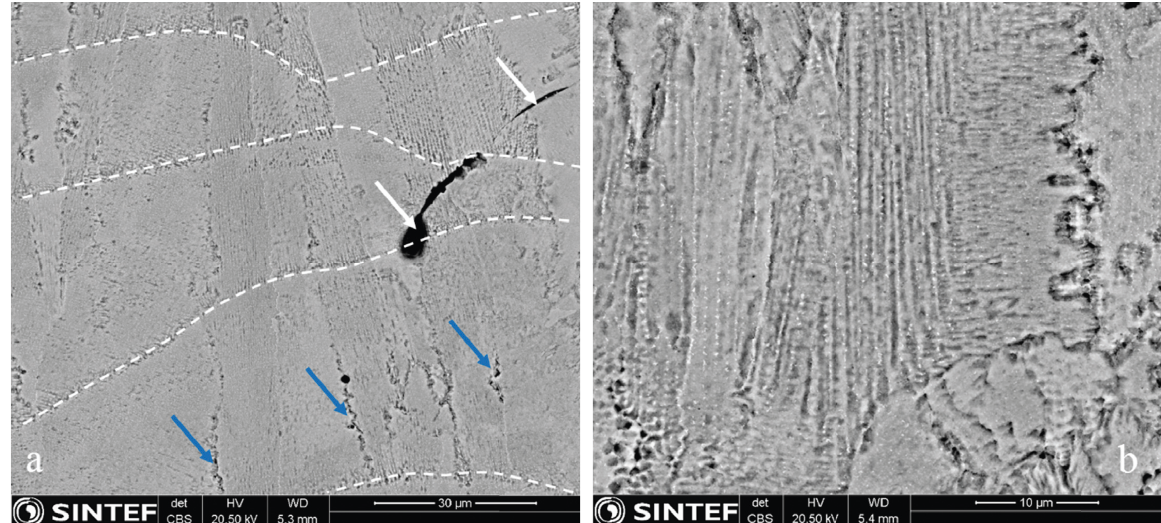
Figure 8: SEM micrographs from the solution-treated samples (Set 1) (a) showing the fusion lines, white arrows show the lack of fusion due to laser parameters and blue arrows show the inter-dendritic regions. (b) showing the dendritic c + c ″ lamellae structure.